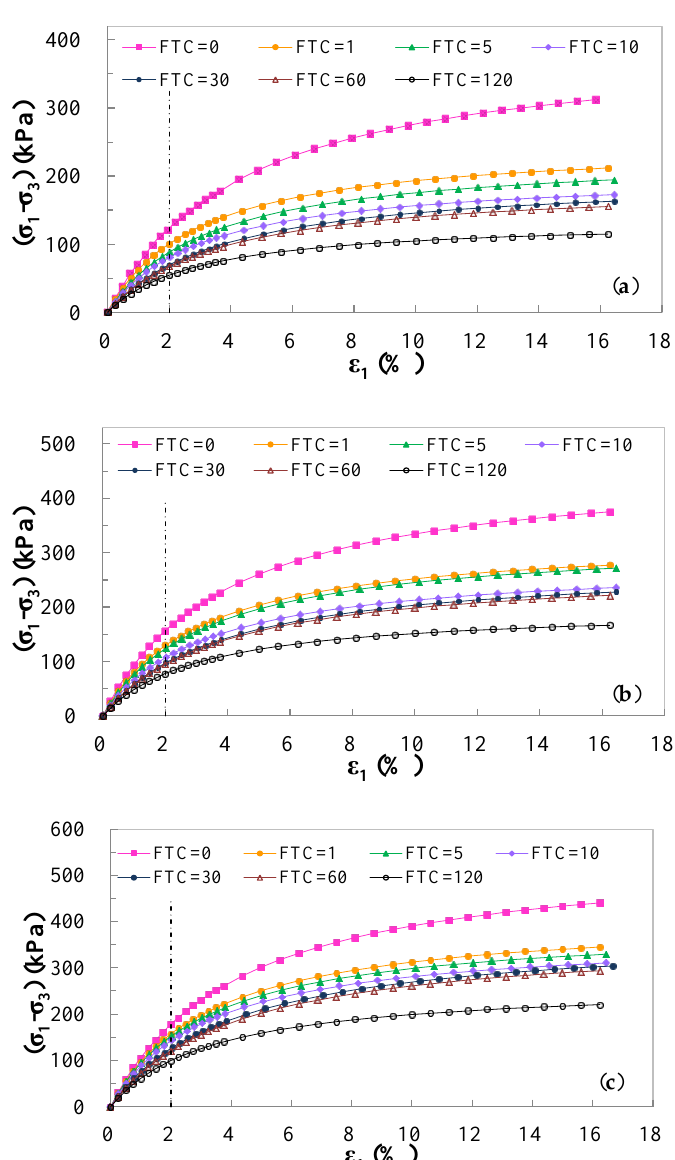
Figure 1. Stress-strain curves of samples with 0.5% salt content. ( a ) σ 3 = 100 kPa; ( b ) σ 3 = 200 kPa; ( c ) σ 3 = 300 kPa.